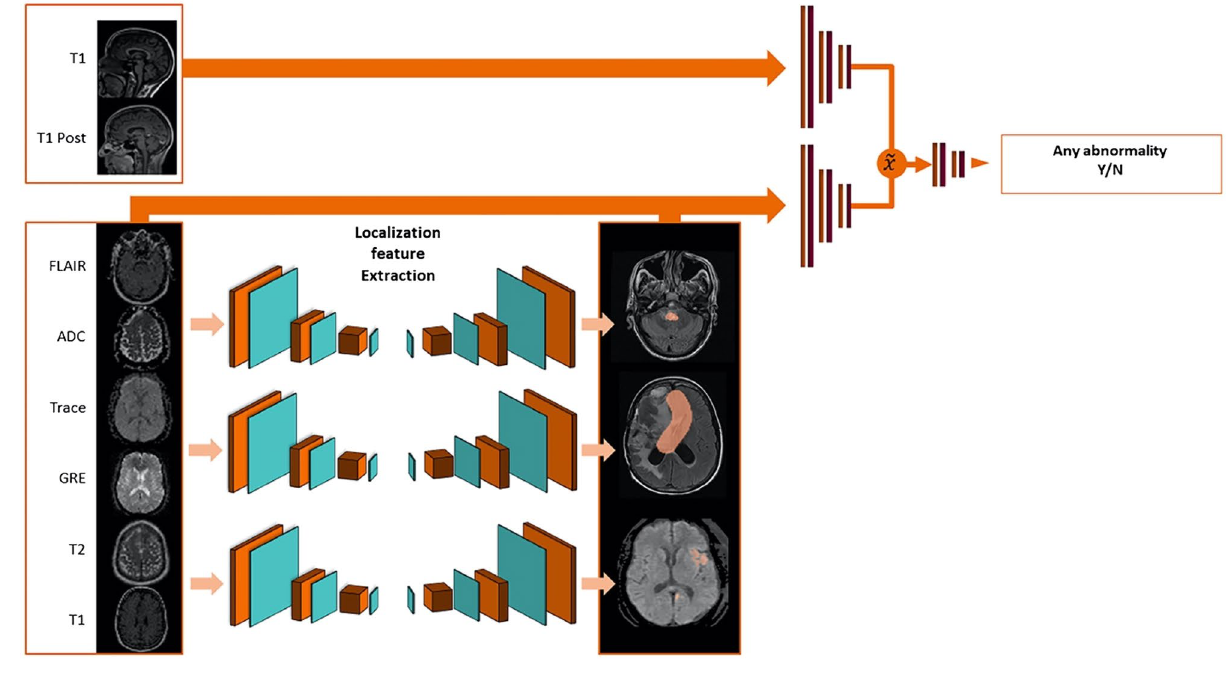
Figure 2. Abnormality network architecture.